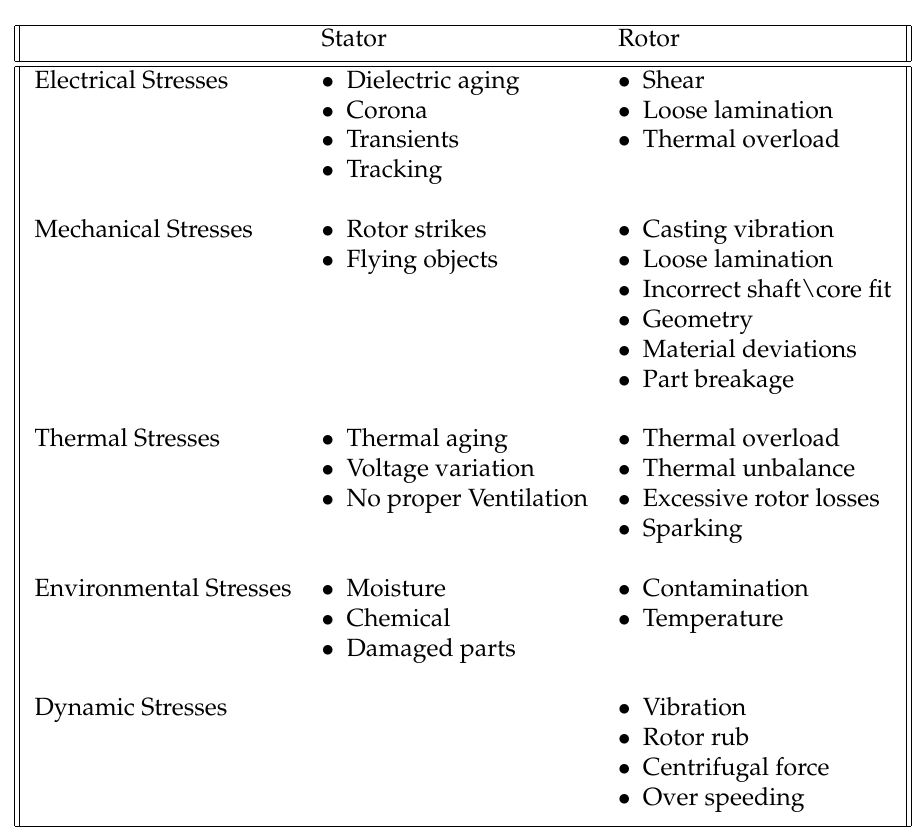
Table 1. Various stresses effects on SAASMs